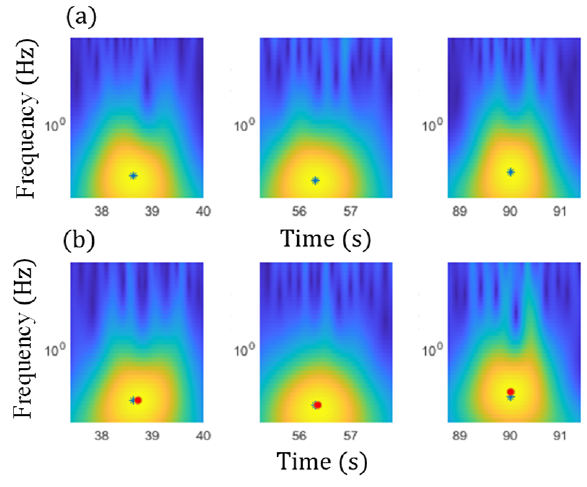
Figure 20. Peak identification within the identified WOIs under the single traffic event for ( a ) strain, 𝐹(𝑡) , measurement, and ( b ) ∆𝐶(𝑡) from SEC.